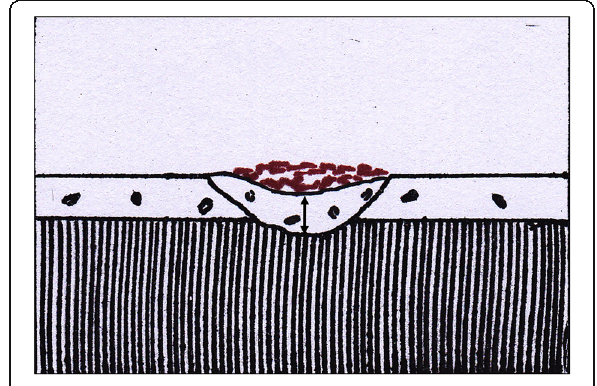
Fig. 5 Schematic fig. to show the method of measuring repair cementum thickness. Measured as perpendicular distance from the deepest point of the crater till the outer surface of the layer ( double-headed arrow